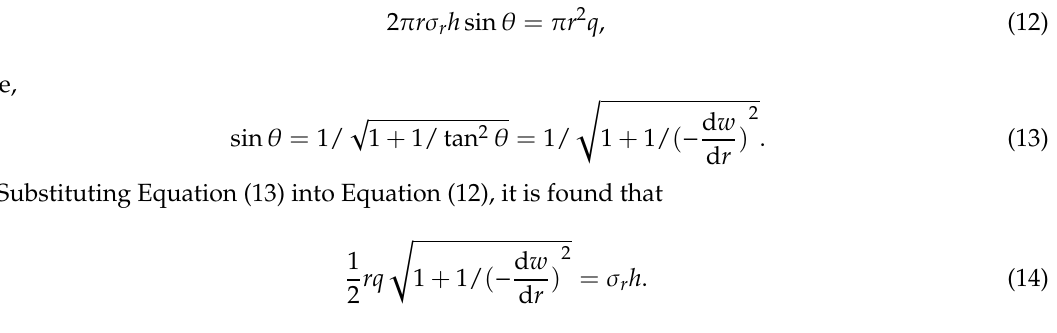
Figure 6. Sketch of the static equilibrium of the